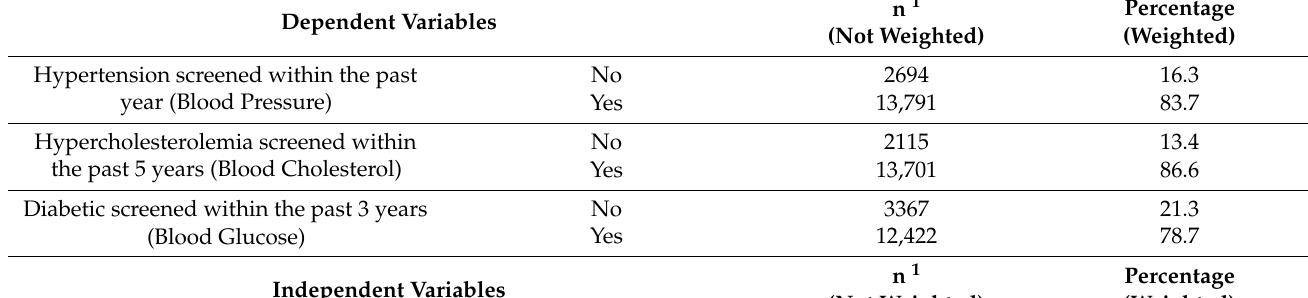
Table 2. Descriptive of the study sample (N = 31,997): NHIS